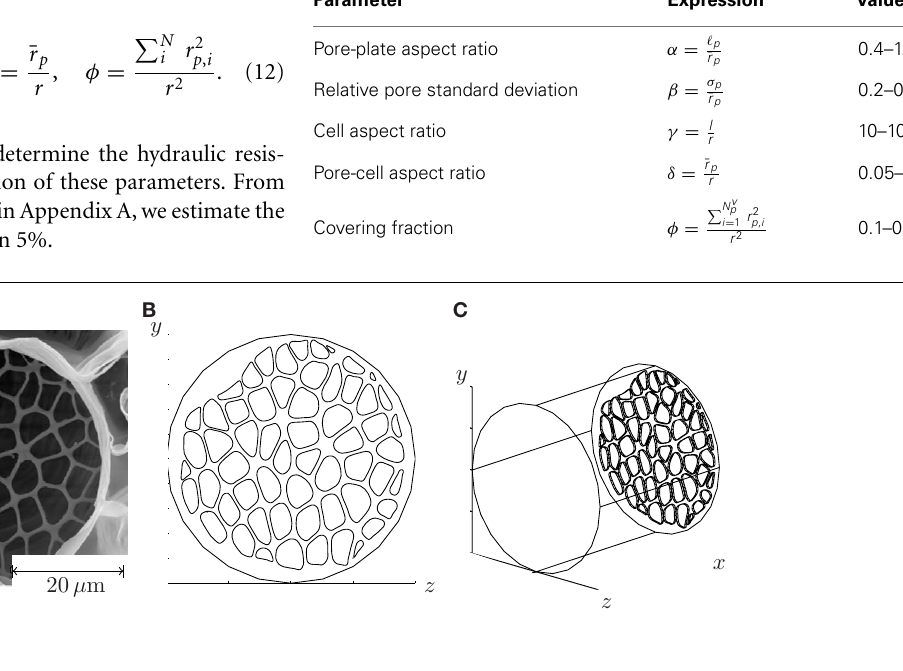
Front view of the pore structure extracted from (A) . (C) The plate has been place inside a cylindrical tube, cf. the computational domain shown in Figure 1A